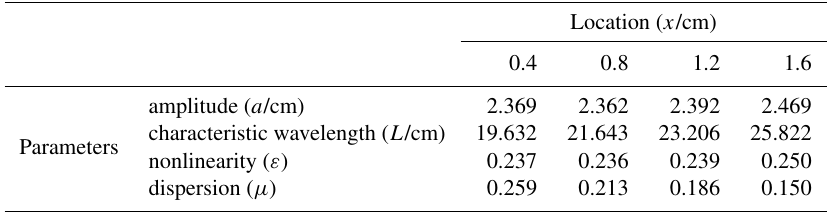
Figure 5. (a) The density time series of 1026kgm − 3 at the four high-frequency output locations from the west to east. The left red and blue arrow lines indicate the eastward and westward waves, and the right arrow line after 120s indicates the eastward-reflected waves from the channel start. (b) Hovmöller diagram showing the density σ at z = 2 . 0cm, where the time interval is 0.1s. Table 1. The characteristics of the depression heading wave at the four